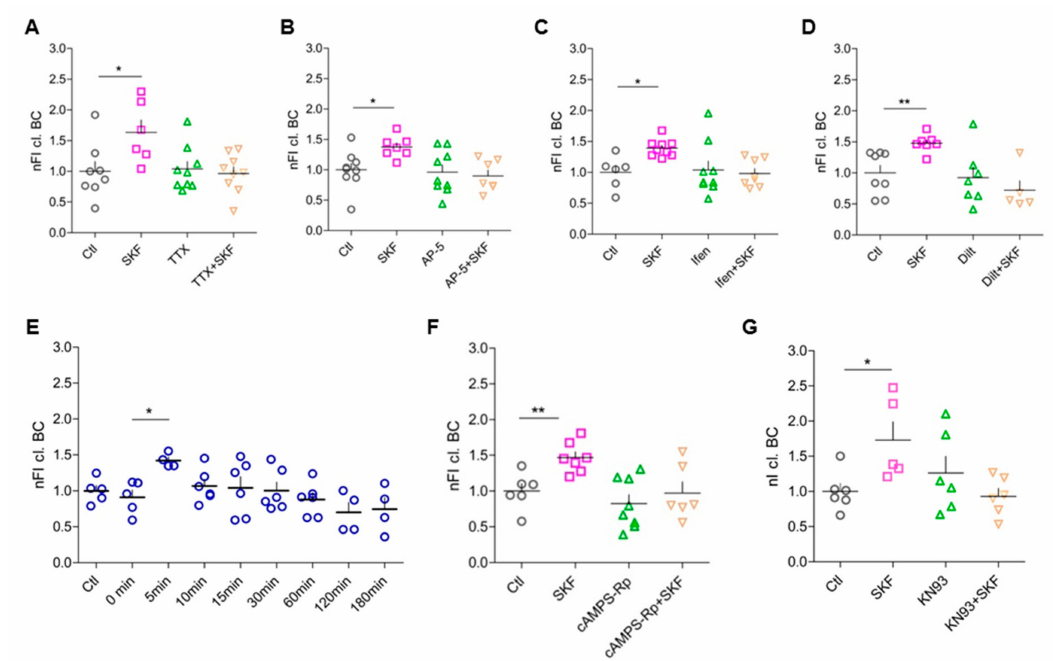
Figure 4. SKF81297-induced BC cleavage requires entire network activity, activity of postsynaptic sites, and co-signaling through PKA and CaMKII.( A ) Silencing neuronal networks with TTX resulted in an unaltered BC cleavage (Ctl, 1 ± 0.1599, n = 8; SKF, 1.632 ± 0.2036, n = 6; TTX, 1.039 ±